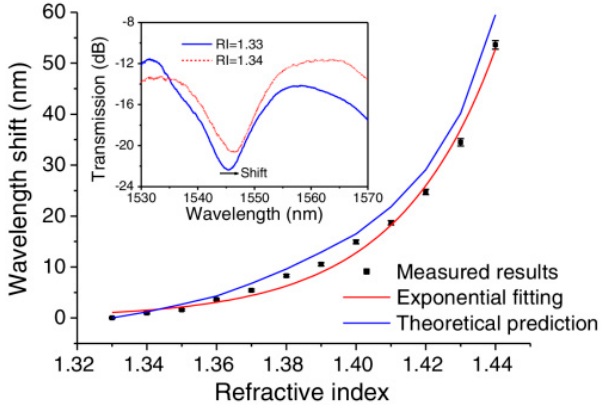
Figure 20. Resonance wavelength shift with RI change [54]. Reproduced with permission from Pengfei Wang, Gilberto Brambilla, Ming Ding, Yuliya Semenova, Qiang Wu, and Gerald Farrell, High-Sensitivity, Evanescent Field Refractometric Sensor Based on a Tapered, Multimode Fiber Interference; published by OSA Publishing, 2011.